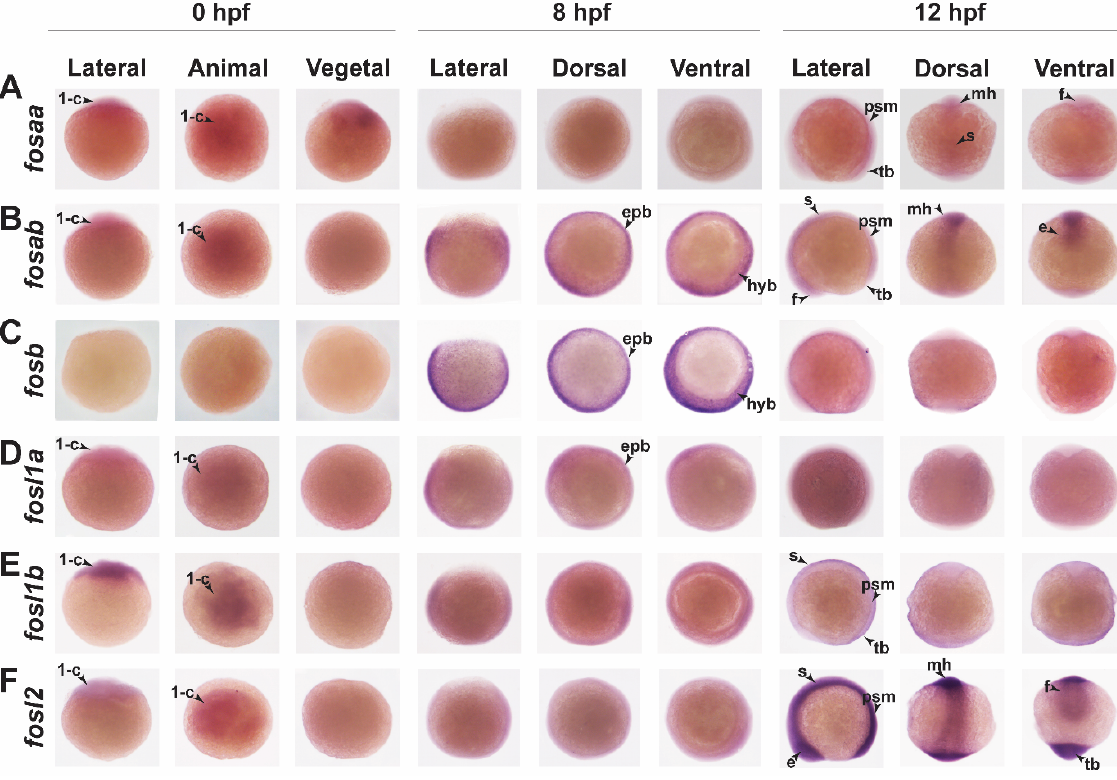
Figure 4. Spatiotemporal expression of fos genes during early zebrafish embryonic development. Lateral, dorsal, and frontal views of 0 hpf, 8 hpf, and 12 hpf zebrafish embryos analysed by WISH showing expression for fosaa ( A ) , fosab ( B ) , fosb ( C ) , fosl1a ( D ) , fosl1b ( E ), and fosl2 ( F ). 1-c, one cell; e, eye; epb, epiblast; f, forebrain; hyb, hypoblast; mh, mid and hindbrain; psm, presomitic mesoderm; s, somite; tb, tailbud. Black arrows within each panel point to the specific expression indicated by the